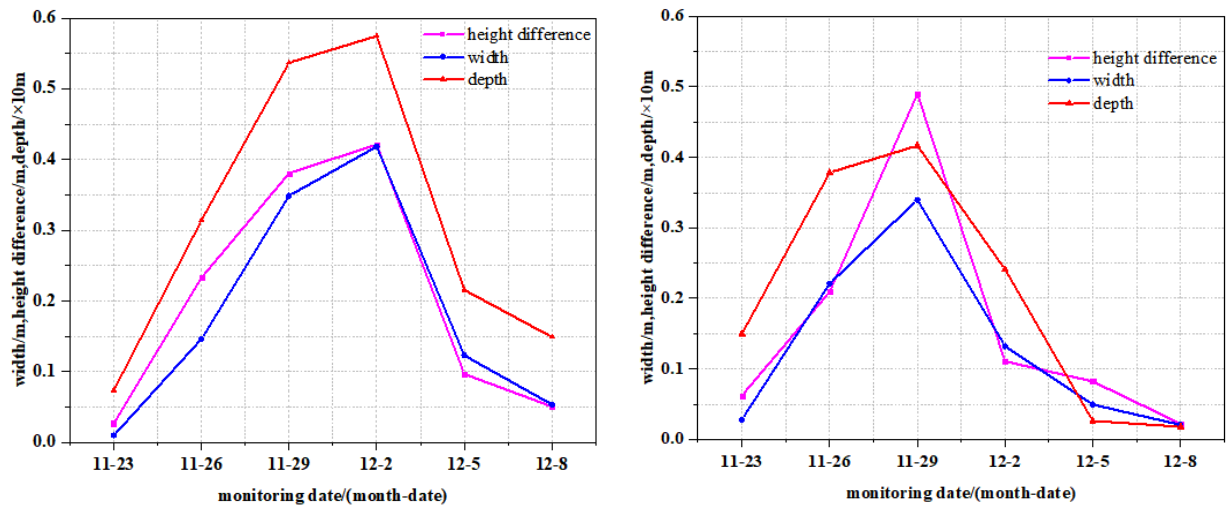
Figure 6. The relationship between the width, drop, depth, and time of ground fissures.